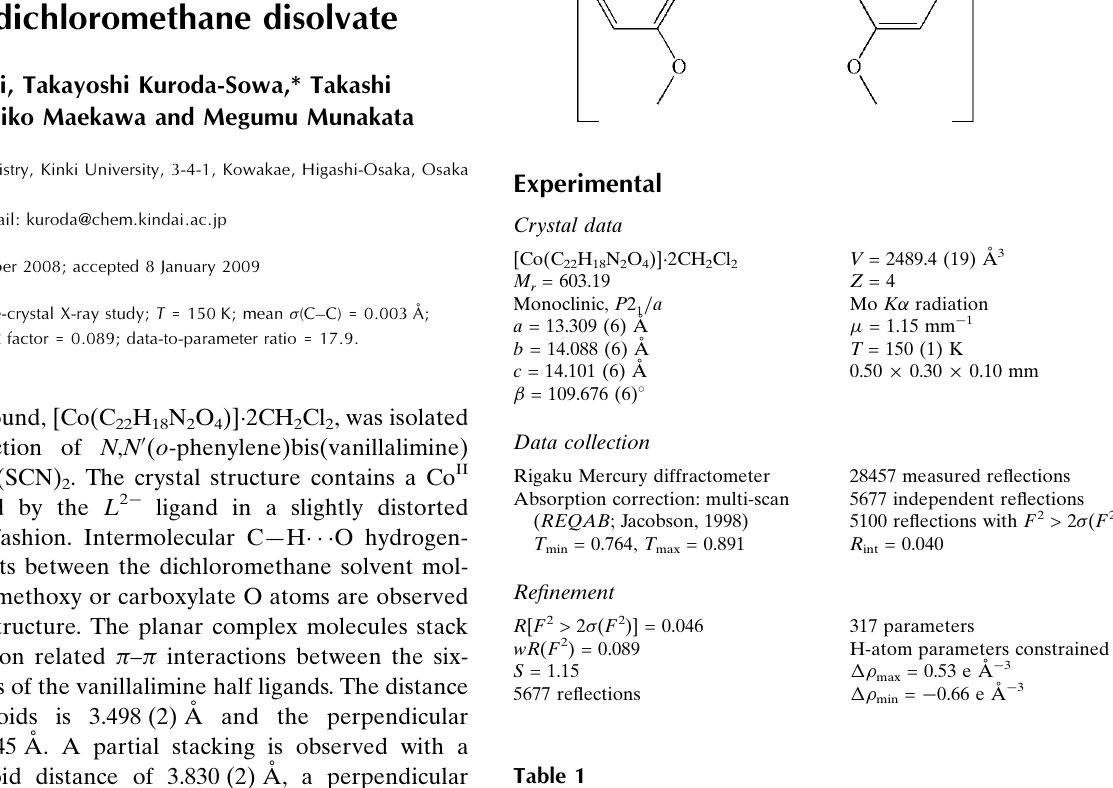
Selected bond lengths (A˚ ).